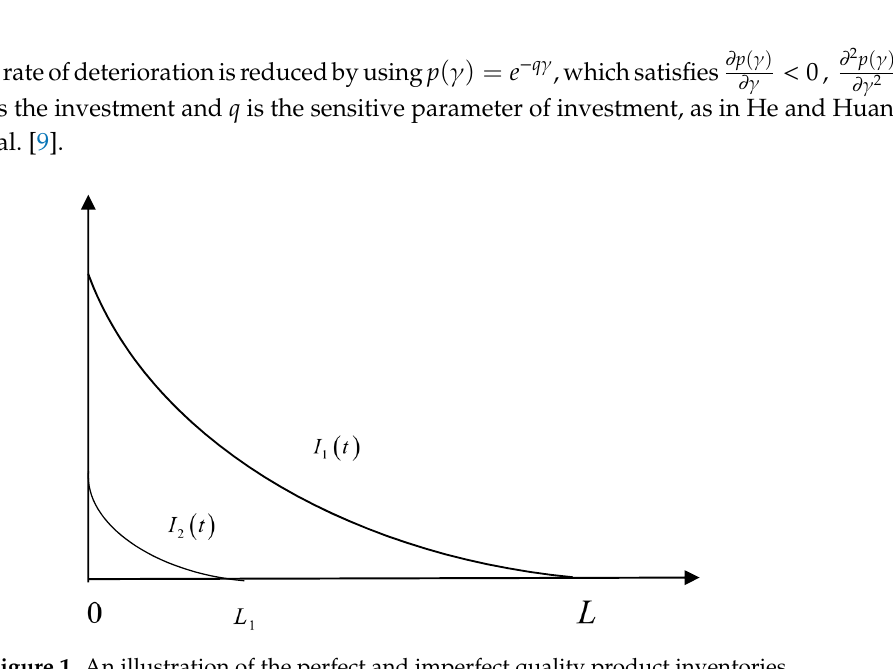
Figure 1. An illustration of the perfect and imperfect quality product inventories.